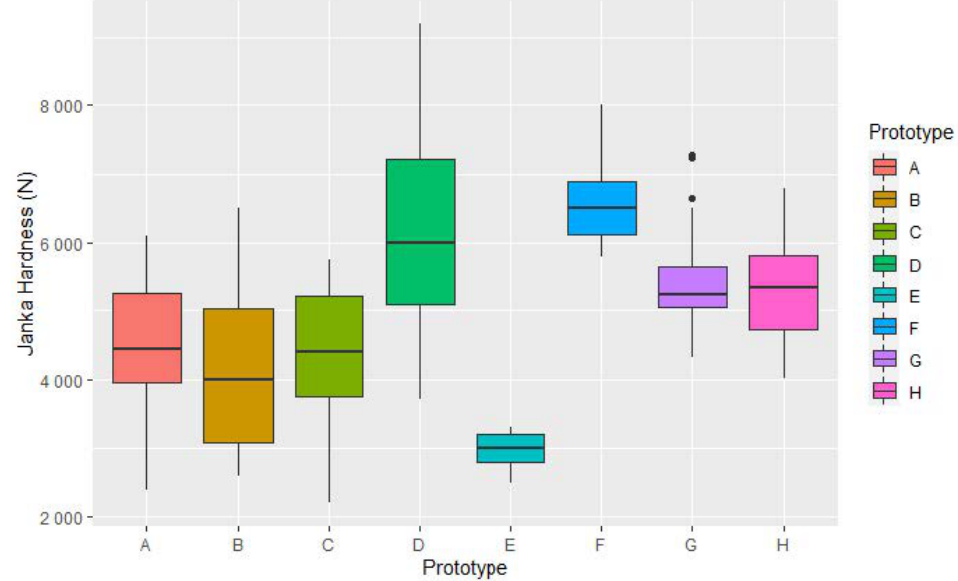
Figure 8. Janka hardness of engineered flooring prototypes and controls .